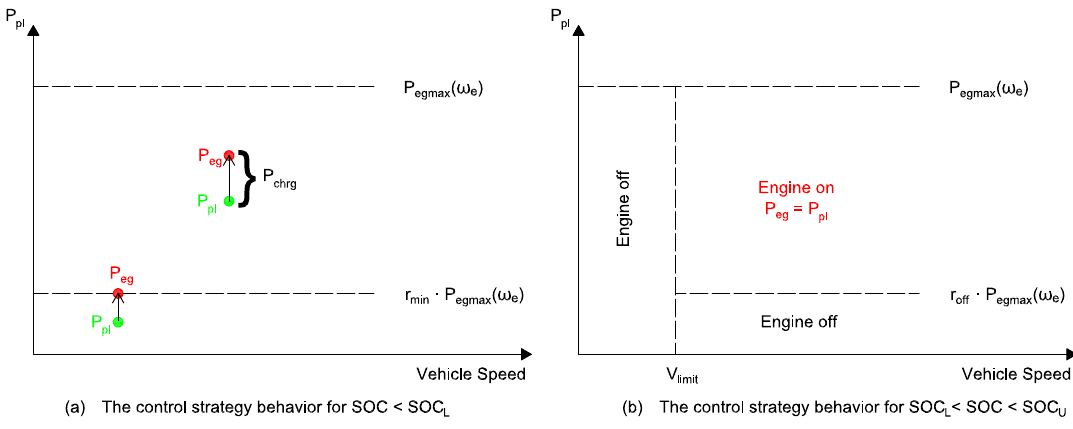
Figure 6. The operating modes of the EACS